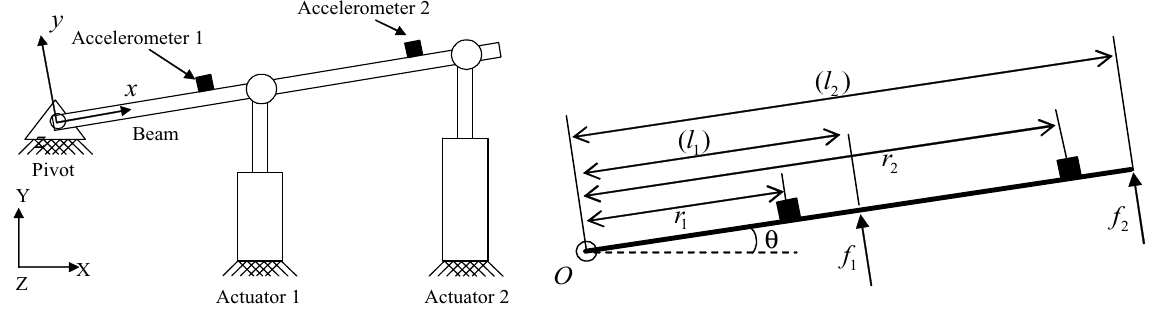
Fig. 6. Single degree of freedom over-actuated